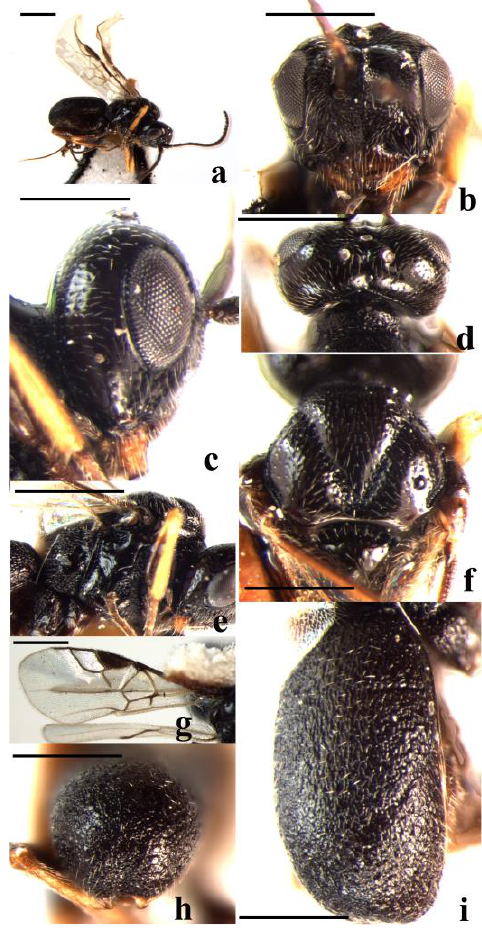
Figure 8. Schizoprymnus telengai Tobias, 1976. ( a ) Habitus, lateral aspect; ( b ) head, frontal aspect; ( c ) head, lateral aspect; ( d ) head, dorsal aspect; ( e ) mesosoma, lateral aspect; ( f ) mesoscutum, dorsal aspect; ( g ) fore wing; ( h ) third metasomal tergite apically, dorsal aspect; ( i ) carapace, dorso-lateral aspect. Scale bar: 1 mm.